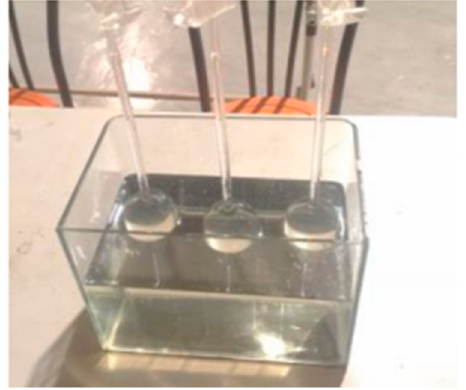
Figure 6. Device for diffusible hydrogen testing.